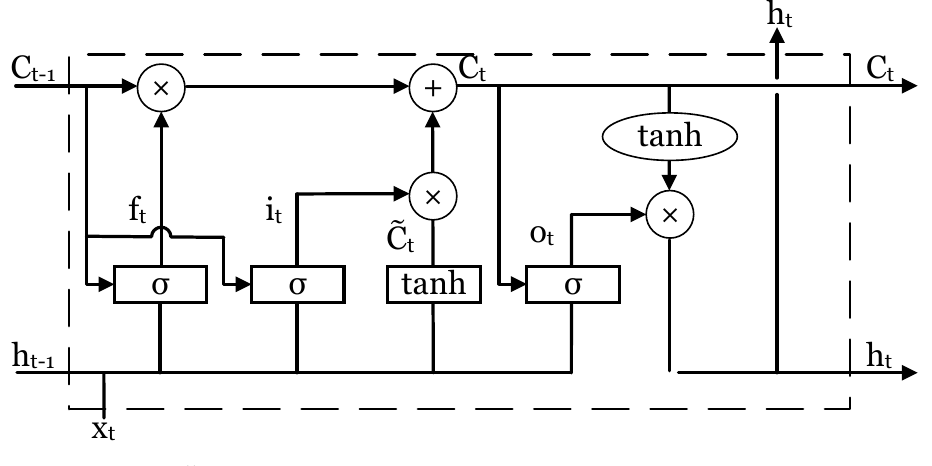
Figure 3. LSTM cell